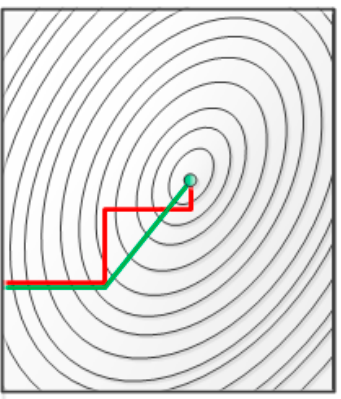
Figure 5. Comparison in searching for the optimal solution path. Green line indicates a conjugate gradient and red indicates a gradient descent.